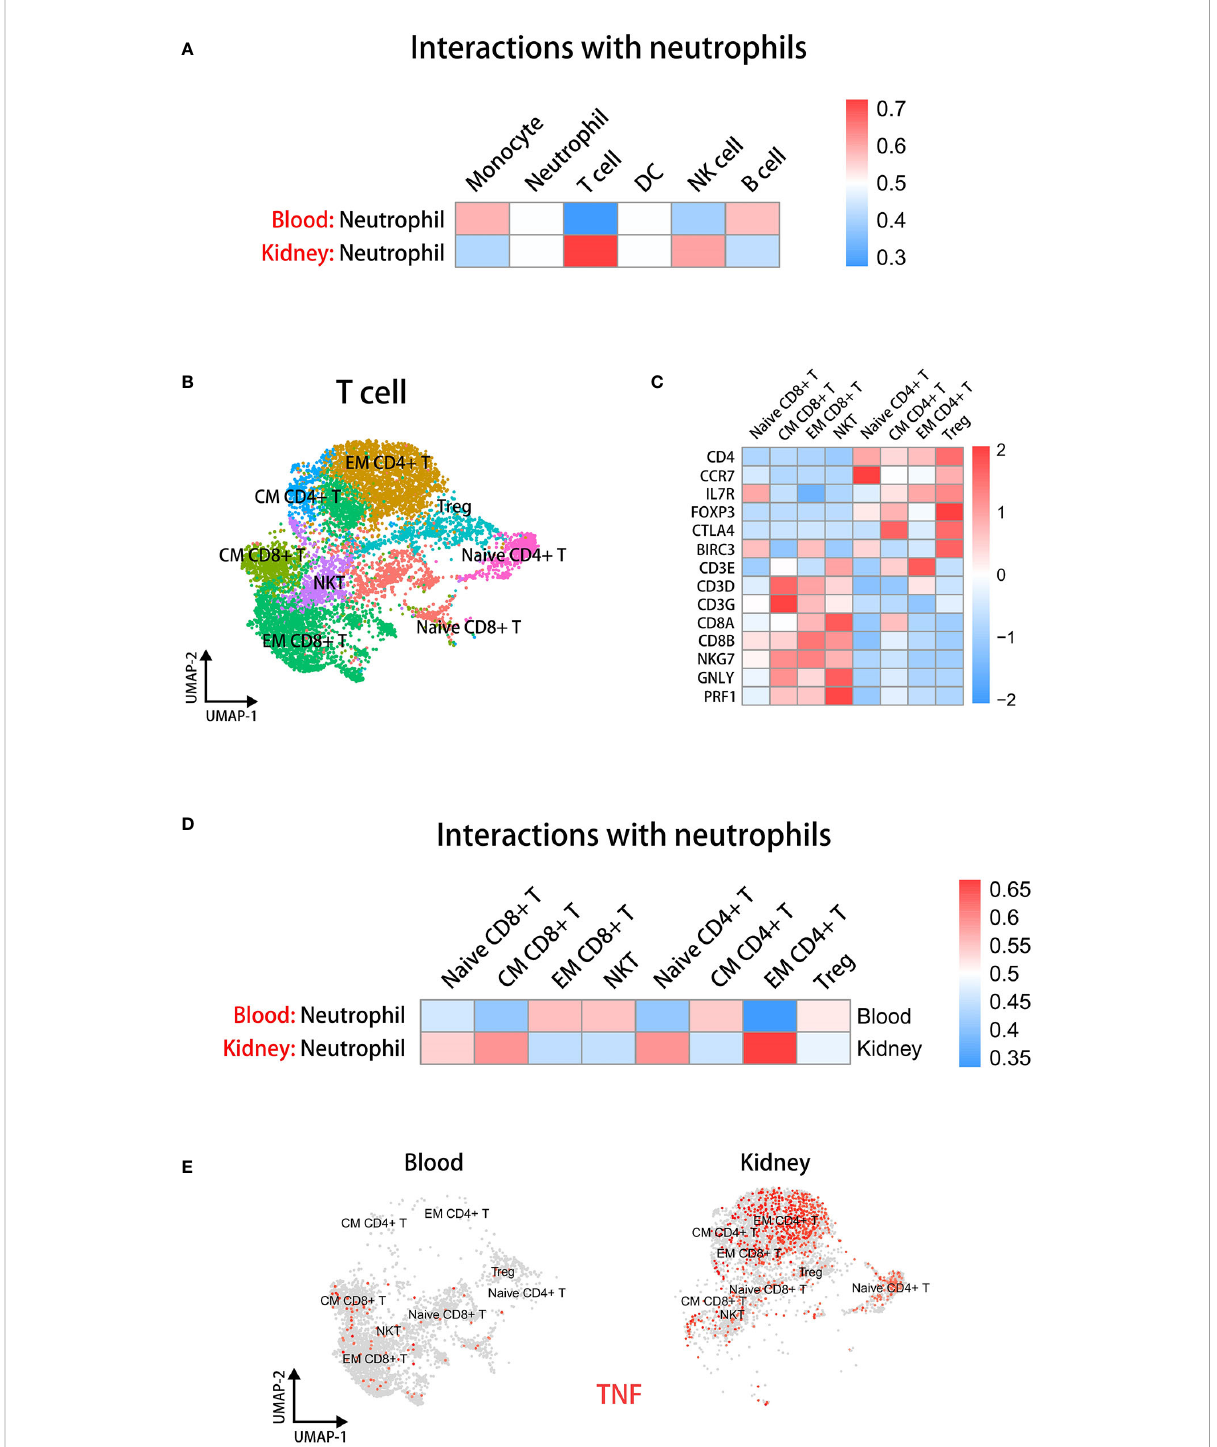
FIGURE 5 Neutrophils have signi fi cant interactions with EM CD4+ T cells in the kidney microenvironment. (A) The cell-cell communication analysis displaying interactions between neutrophils and other immune cells in blood or kidney datasets. (B) The UMAP plot of T cell subsets in blood and kidney datasets. (C) The heatmap showing the expression of marker genes in identi fi ed subsets. (D) The cell-cell communication analysis displaying interactions between neutrophils and T cell subsets in blood or kidney datasets. (E) The UMAP plot colored by TNF in T cell subsets in blood and kidney